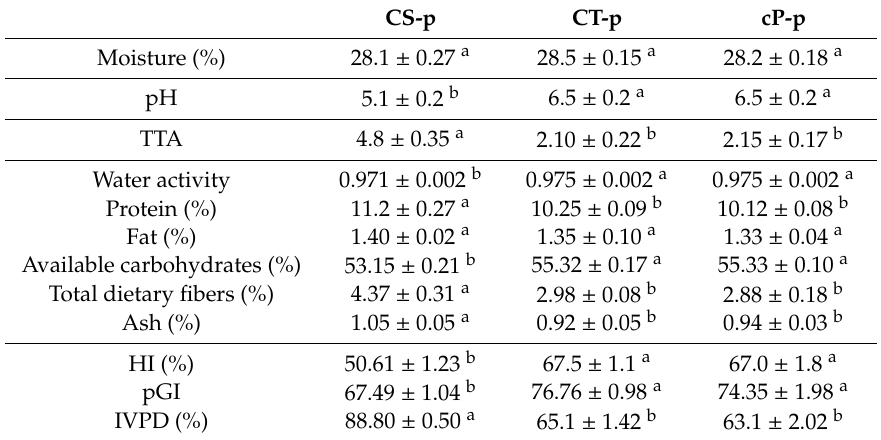
Table 4. Main nutritional properties of the fresh pasta: CS-p, fresh pasta fortified with the chickpea sourdough; CT-p, conventional semolina fresh pasta; CT-p, cP-p semolina fresh pasta added to 0.3% (w / w on a flour weight basis) calcium propionate.